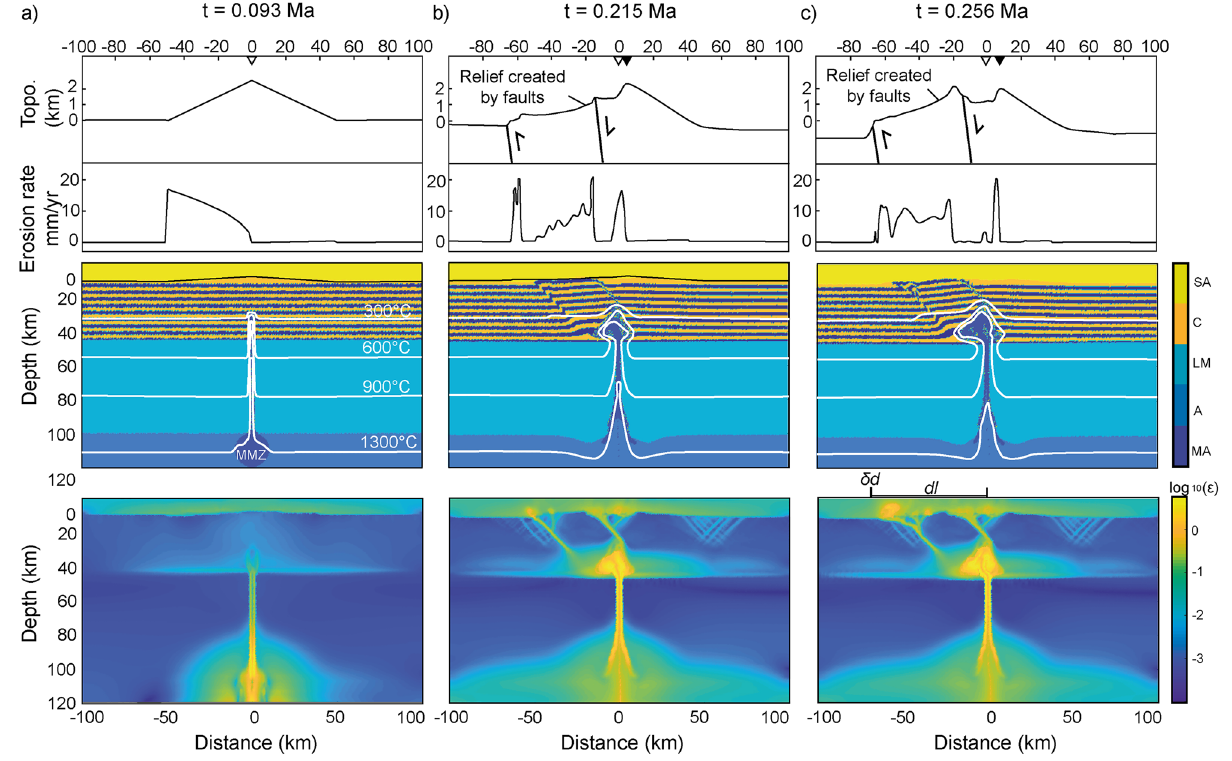
Figure 3. Initial, intermediate and final steps of selected numerical simulation with asymmetric erosion from the second set of simulations (Ch = 35 km, Lh = 100 km, Dmc = 20 km). Topographic profile (8 × vertical exaggeration) and erosion rates (top panels), lithologic and thermal distribution (middle panels), and cumulative bulk strain (lower panels) of the initial state with central topography ( a ), early transient state ( b ), and advanced transient state ( c ). Note the initial water divide (white downward triangle) migrating to the right throughout the simulation (black downward triangle) due to asymmetric erosion and the final asymmetric system of brittle-ductile structures, leading to lateral magma ascent toward the opposite side of the initial topography. Abbreviations are the same as in Fig.